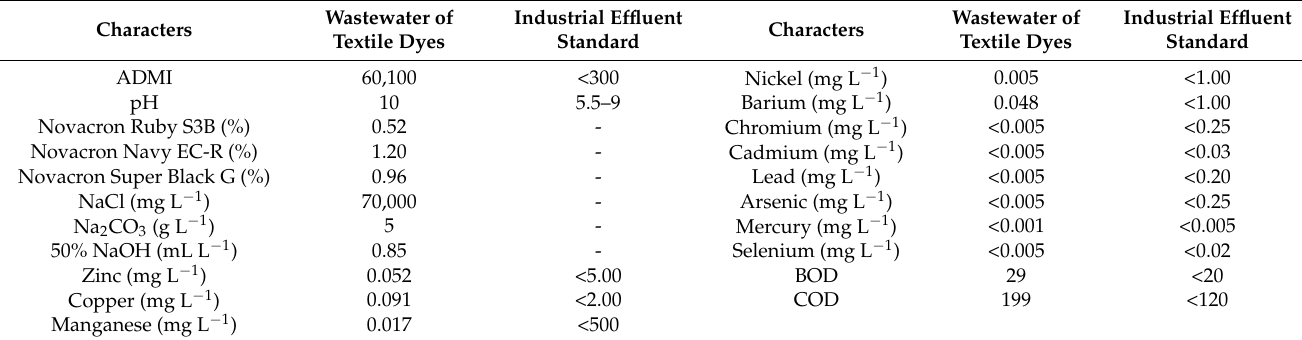
Table 1. Characteristics of textile dyes from industrial